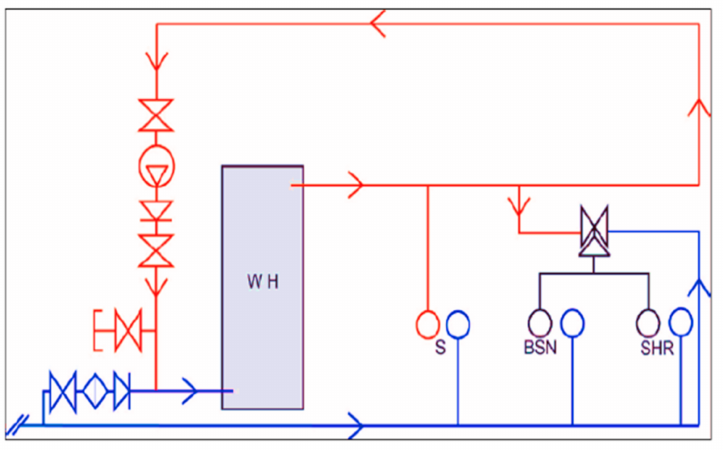
Figure 1. Example of a circulating warm water system controlled by a thermostatic mixing